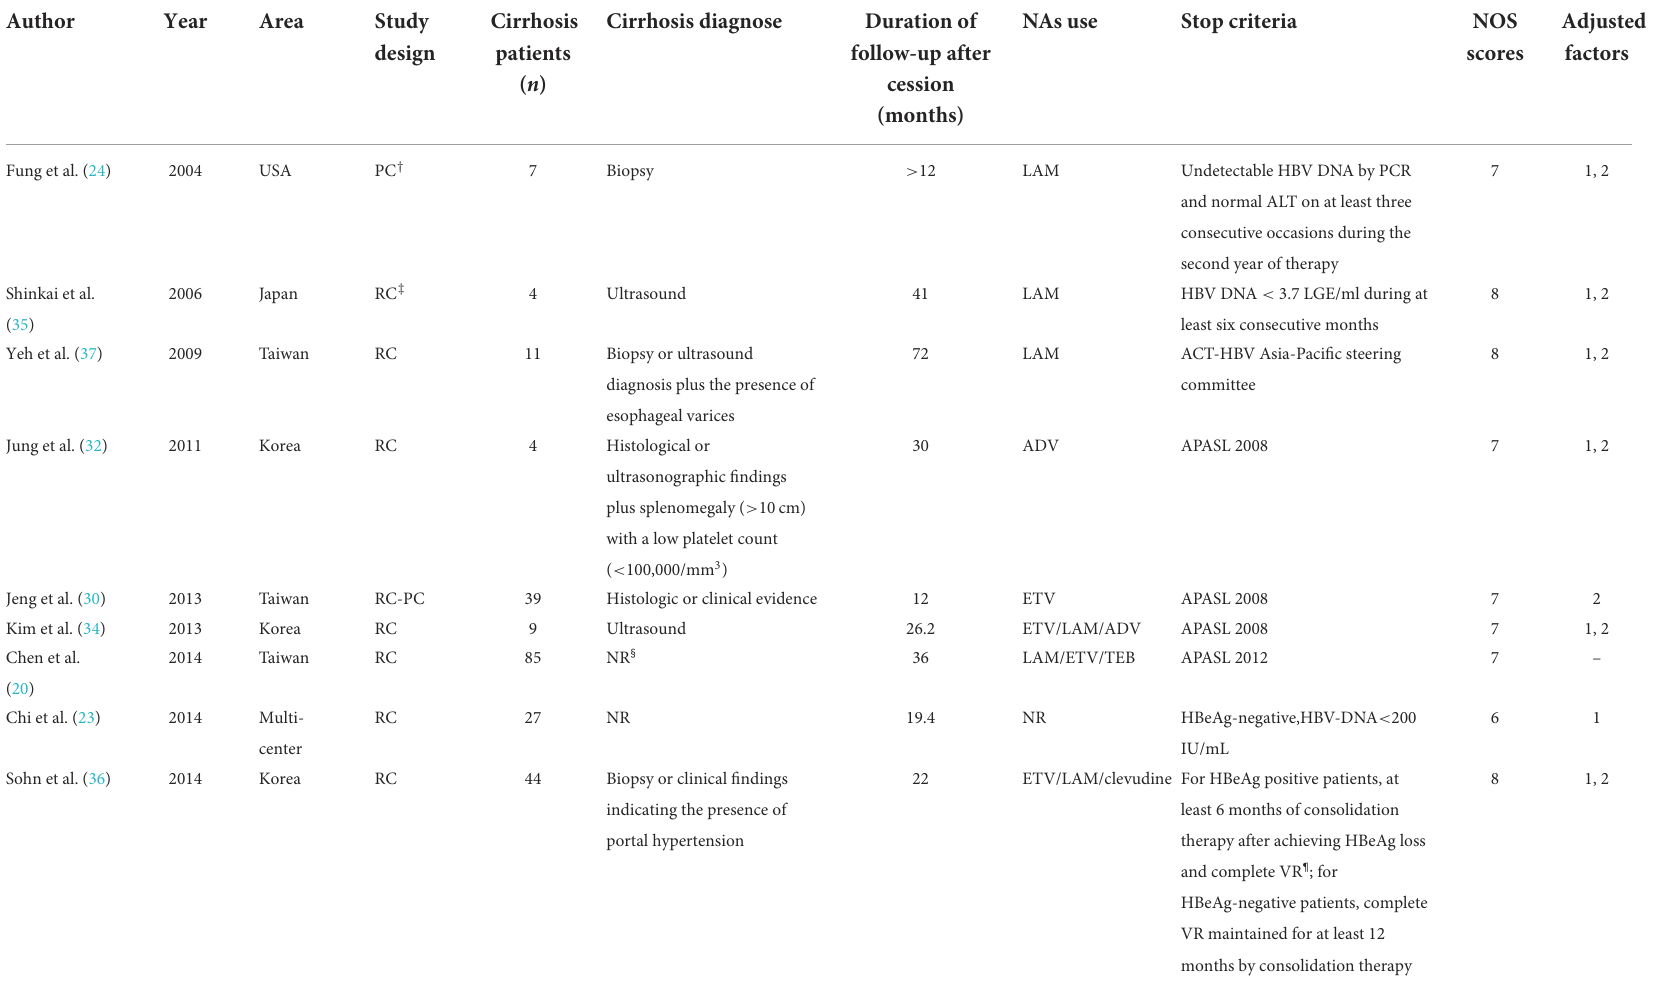
TABLE 1 Characteristics and quality of studies included in the systematic